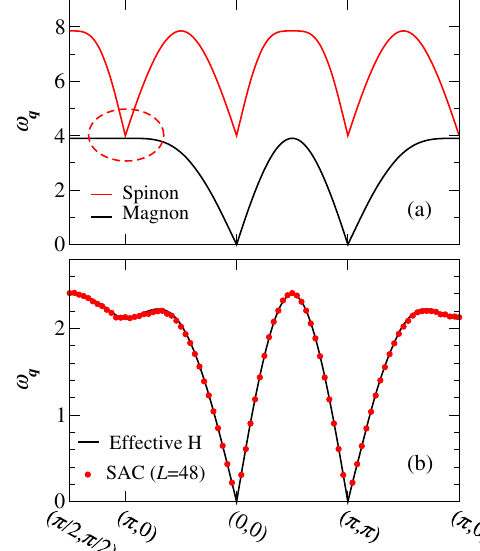
FIG. 16. (a) Dispersions of the bare excitations of the effective model along a path through the BZ. The lower branch is for the magnon, and the upper branch is for a single spinon. The latter is also the lower edge of the two-spinon continuum. In this example, the spinons in the circled region close to q ¼ ð π ; 0 Þ almost touch the magnon band, leading to significant spinon-magnon mixing. (b) The black curve shows the lowest energy of the mixed spinon- magnon system obtained with the dispersions in panel (a) and strength g ¼ 5 . 1 of the mixing term. The red circles show the results of the QMC-SAC calculations for the Heisenberg model on the L ¼ 48 lattice from Sec. III.